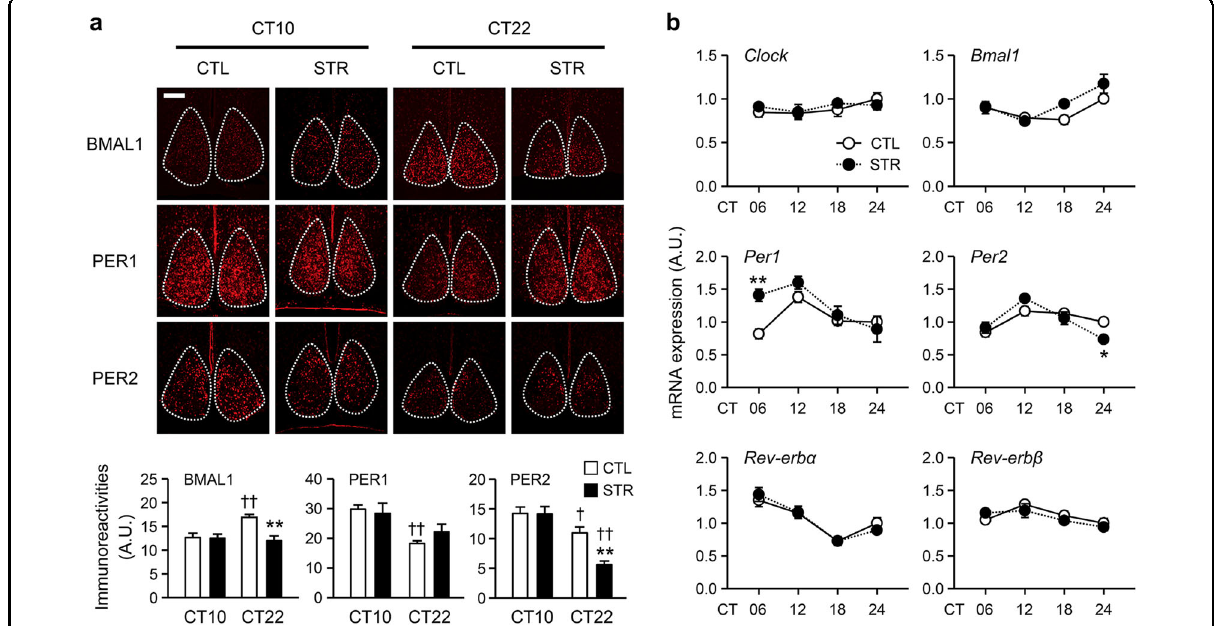
Fig. 3 Expression levels of core clock genes in the SCN of adult male offspring. a Representative images of BMAL1, PER1, and PER2 protein expression in the SCN, which is marked by the dashed lines (scale bar = 50 µm). The fl uorescence intensities of the indicated proteins in the SCN were normalized against the DAPI signal and are presented as the mean ± SE ( n = 19 – 36 cells from three independent slices from different mice in each group; ** p < 0.01 between CTL and STR at the corresponding time point; † p < 0.05 and †† p < 0.01 between CT10 and CT22 by Bonferroni post hoc comparison). b mRNA expression pro fi les of clock genes in SCN-AH fragments from CTL and STR mice. The data were normalized against TATA- binding protein (TBP) expression levels and are expressed as the mean ± SE in arbitrary units (A.U.), with the mean CTL value at CT24 being de fi ned as 1 ( n = 4 for each time point; * p < 0.05 and ** p < 0.01 between CTL and STR by Bonferroni post hoc